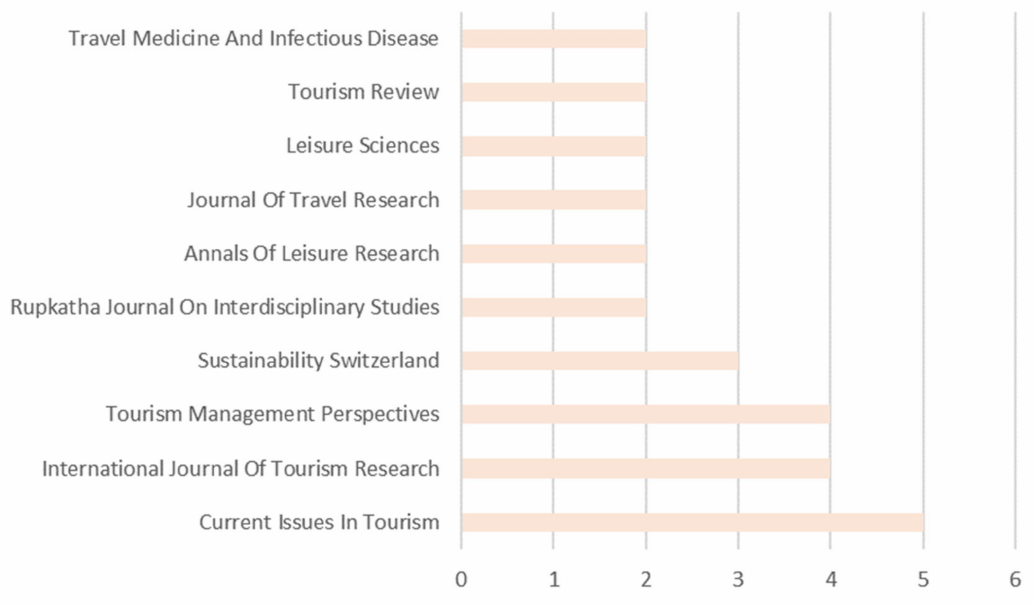
Figure 4. Top journals contributing to the subject of “Solo Travel” (at least two articles